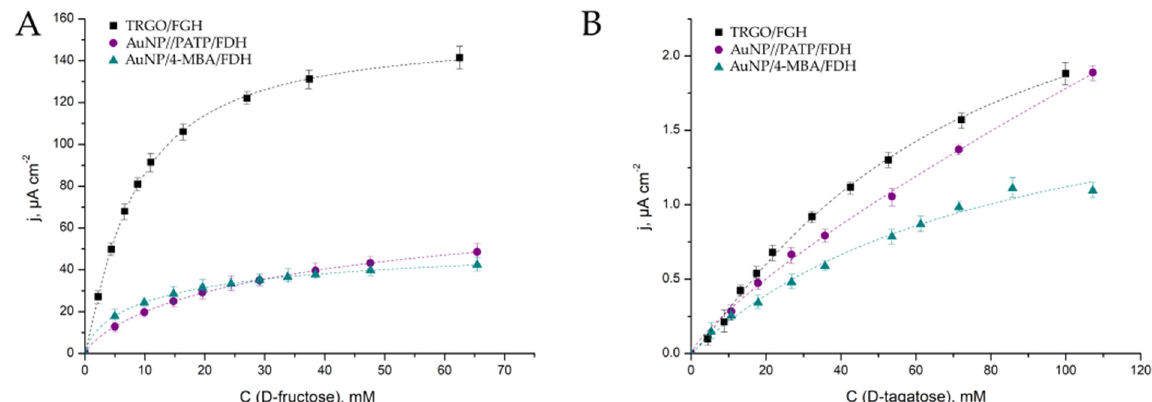
Figure 5. Calibration graphs for three types of sensors for changing concentrations of D-fructose ( A ) or D-tagatose ( B ). Concentrations measured under potentiostatic conditions at 0.4 V vs. Ag/AgCl in a stirred McIlvaine buffer solution, pH 4.5, 20 °C. The experimental data are fitted by using the Michaelis–Menten equation.